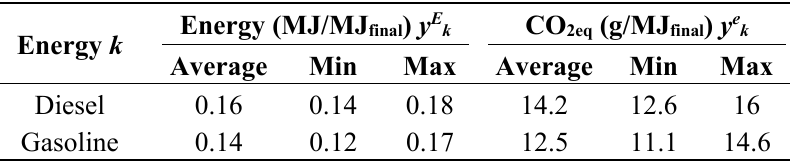
Figure 2. Life cycle stages simplified flow chart applied to a car lifetime. Table 3. Energy and emissions WTT factor (MJ and gCO 2eq per MJ of final energy consumed at the vehicle)